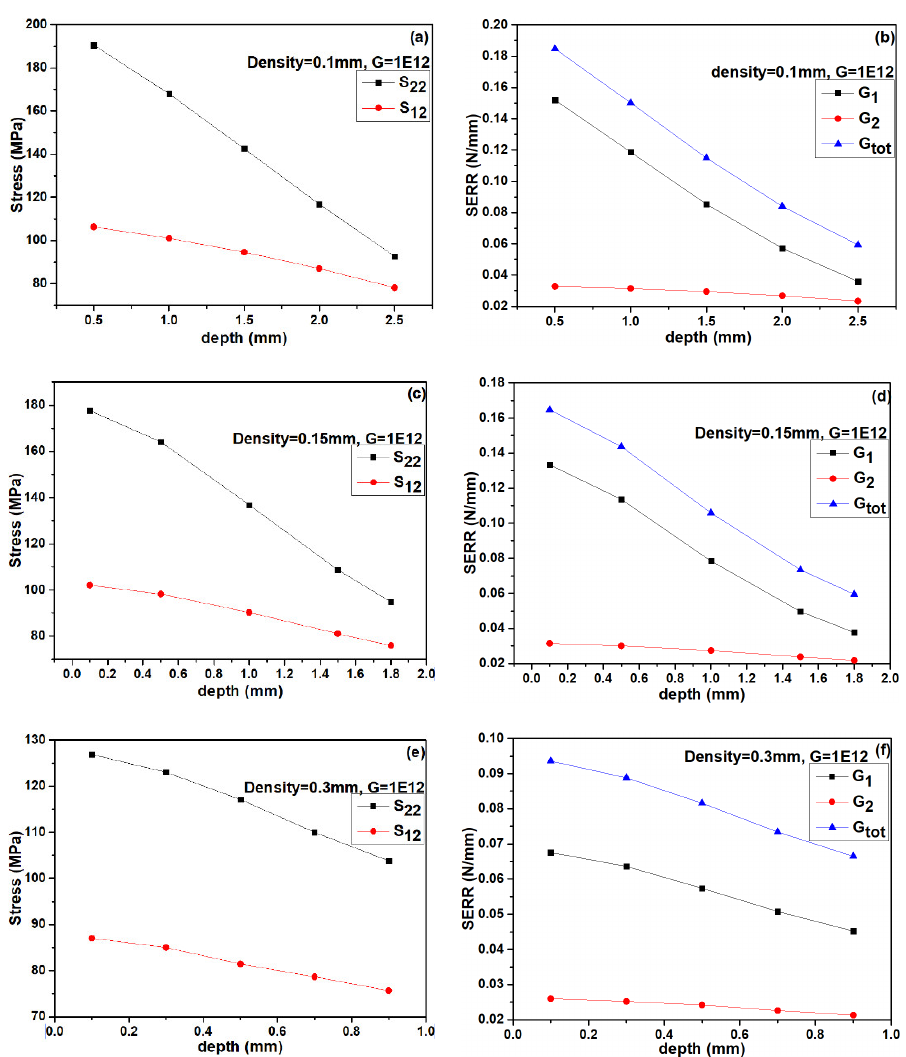
Figure 14. Effect of crack density and crack depth on stress and SERR: stresses at density ( a ) 0.1 mm, ( c ) 0.15 mm, ( e ) 0.3 mm and SERR at density ( b ) 0.1 mm, ( d ) 0.15 mm, ( f ) 0.3 mm.